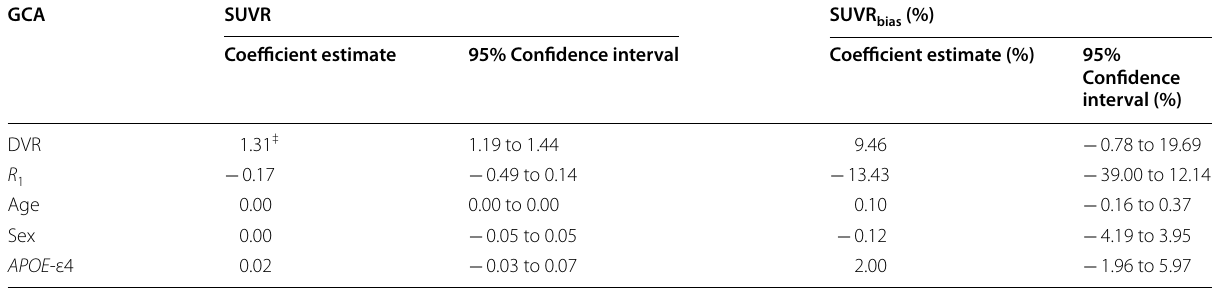
Table 3 Relationship between (bias in) SUVR and independent variables for [ 18 F]florbetaben